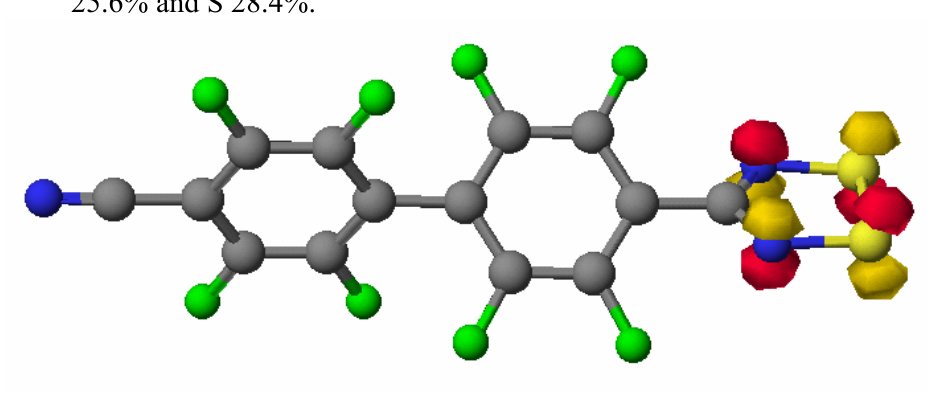
Figure 4: Spin density distribution in 4 , determined from ab initio DFT calculations. Spin densities at the heterocyclic ring are: (B3LYP/6-31G**) C -7.5%, N 25.6% and S